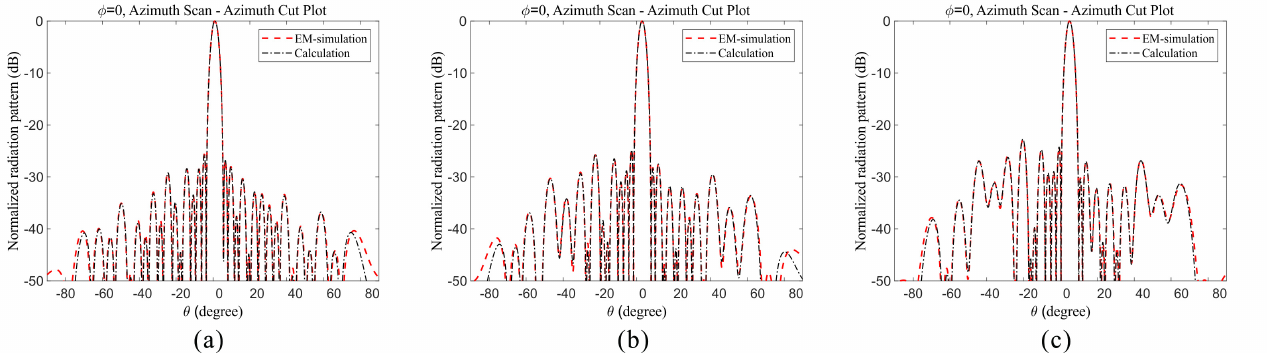
Figure 12. Radiation pattern when scanning the azimuth at 30 GHz (calculation vs. EM full-wave simulation): ( a ) 1 ◦ scanning, ( b ) 3 ◦ scanning and ( c ) 5 ◦